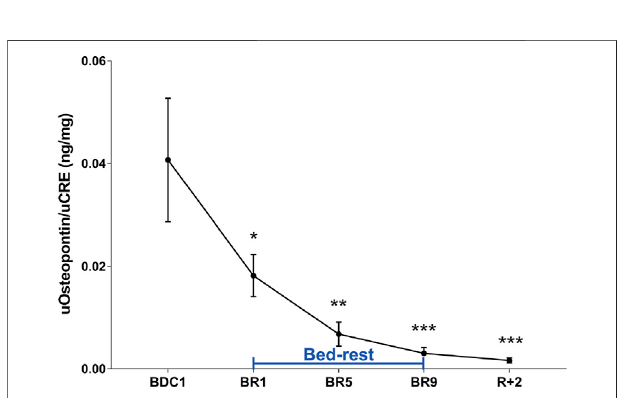
FIGURE 5 | Urinary Osteopontin (OPN) excretion normalized to Creatinuria (ng/mg) during 10-day bedrest. Data are expressed as mean ± S.E.M. Statistical analysis was done using Ordinary one-way Anova test (* p < 0.05 for BR1 vs. BDC1; ** p < 0.01 for BR5 vs. BDC1; *** p < 0.001 for BR9 and R+2 vs.